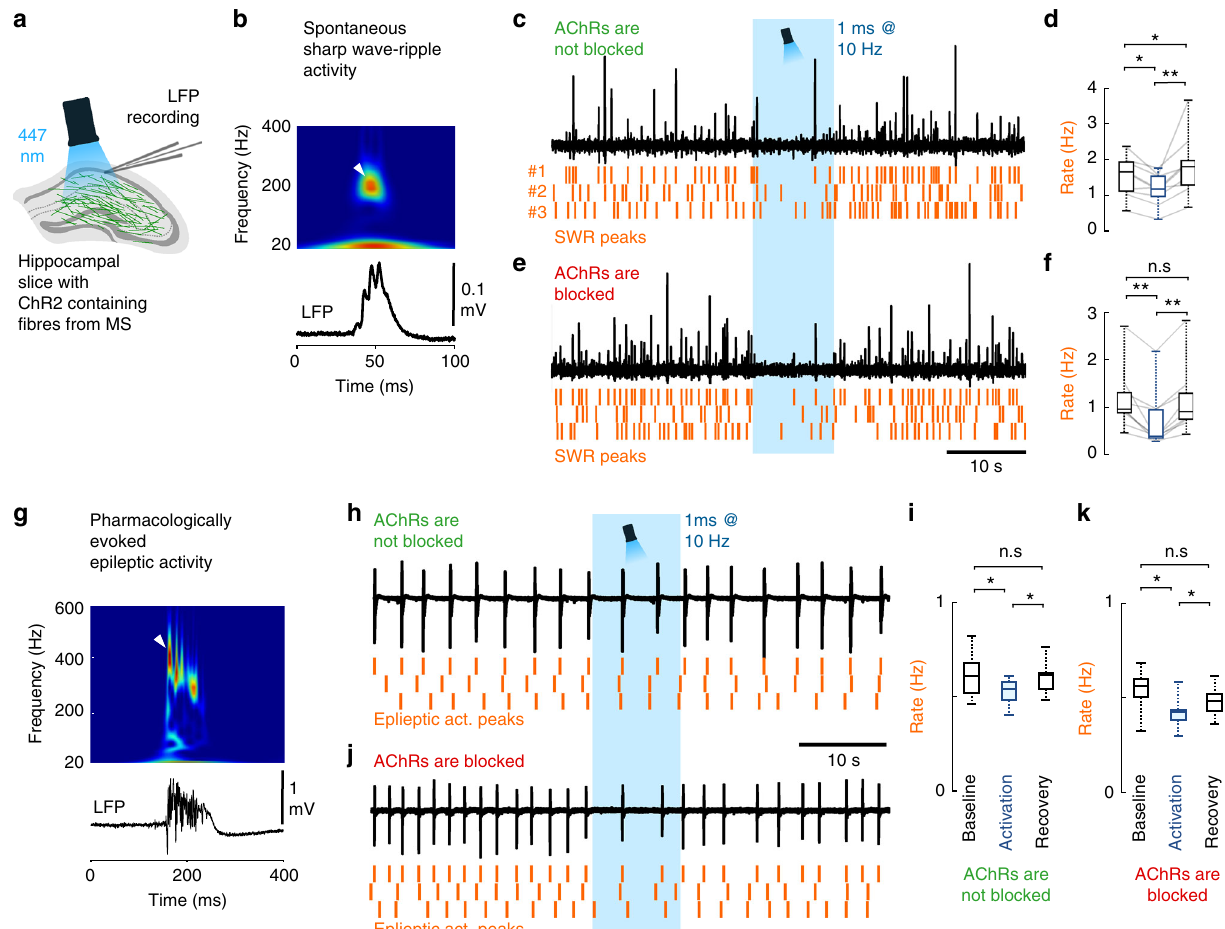
Fig. 6 GABA release from cholinergic terminals controls healthy and pathological hippocampal network activity. a To understand the functional impact of GABA and acetylcholine co-transmission onto cortical network oscillations, local fi eld potential (LFP) was recorded with standard patch pipettes from the CA1 area of thick hippocampal slices. These slices generated healthy and pathological in vivo like activity patterns. Cholinergic fi bres expressing ChR2 were illuminated with blue light in the presence, or in the absence of AChR blockers parallel with LFP recordings. b A spontaneous sharp wave-ripple (SWR) LFP signature (bottom), and its wavelet transform (top) highlighting the characteristic ripple-band frequency component (~200 Hz, white arrowhead). c , d LFP recording from hippocampal CA1 in the absence of AChR blockers ( n = 9). Orange raster indicate SWR peaks for three consecutive stimulation periods. Optical stimulation decreased SWR rate signi fi cantly ( d ), then SWR rate increased temporarily after the cessation of optical stimulation (median values, interquartile ranges and min/max values, for data see Supplementary Note 8). e , f After we blocked AChRs (1 µ M MLA, 1 µ M DH β E, 10 µ M atropine), LFP recording from CA1 ( n = 9) showed that GABA release from cholinergic fi bres alone could decrease SWR rate even more effectively ( f ). There was no SWR rate increase after the cessation of optical stimulation (median values, interquartile ranges and min/max values, for data see Supplementary Note 8). g Epileptiform activity was evoked by elevating K + concentration in the ACSF to 8.5 mM in slices. LFP (bottom) and its wavelet transform (top) shows the signature of a pharmacologically evoked epileptiform events. Note the robust differences in amplitude, length and frequency components compared to physiological SWR activity (Fig. 6b) that is consistent with literature data 41 . h , i Epileptic activity recorded in CA1 in the absence of AChR blockers ( n = 7). Orange raster indicate detected epileptic activity peaks for three consecutive stimulation periods. Illumination of cholinergic fi bres reduced the rate of epileptic events ( i ), which recovers after the cessation of optical stimulation (for data see Supplementary Note 8). j , k Epileptic activity recorded in CA1 in the presence of AChR blockers ( n = 8). Even in the presence of AChR blockers, illumination of cholinergic fi bres reduced the rate of epileptic discharges ( k ), which recovers after the stimulation (median values, interquartile ranges and min/max values, for data see Supplementary Note 8), suggesting